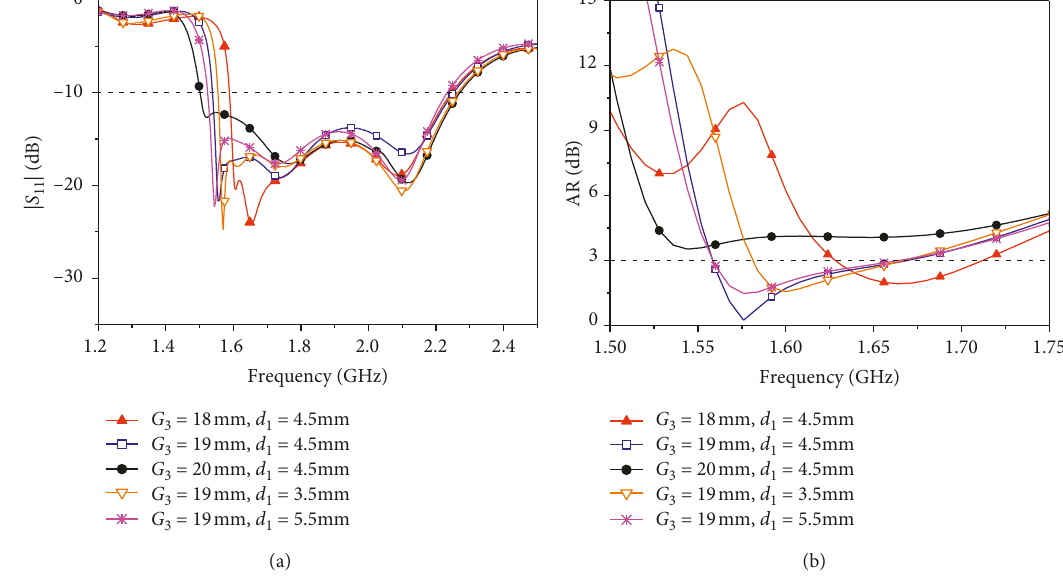
Figure 8: Variations of (a) | S 11 | and (b) AR with different dimensions of the center ring of the reflector, G 3 and d 1